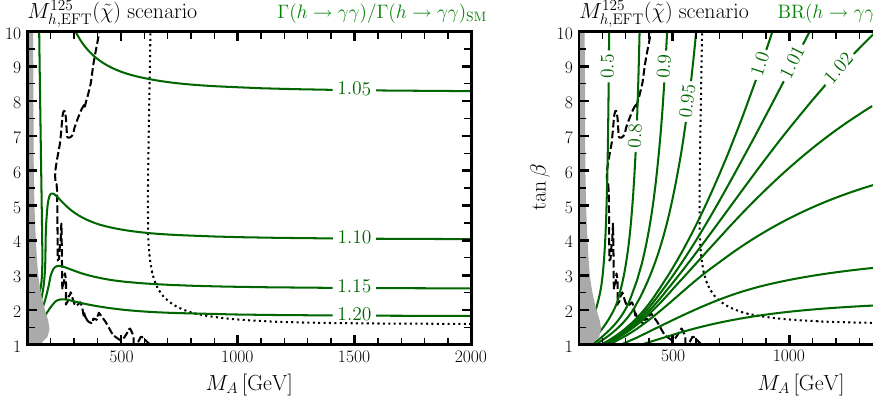
Fig. 6 Left : Decay width of the light CP -even Higgs boson h into pho- tons( greencontourlines )inthe( M A ,tan β )planeinthe M 125 nario,normalizedtothecorrespondingSMprediction. Right :Branching ratio of the decay h → γγ , normalized to its SM prediction ( green con-